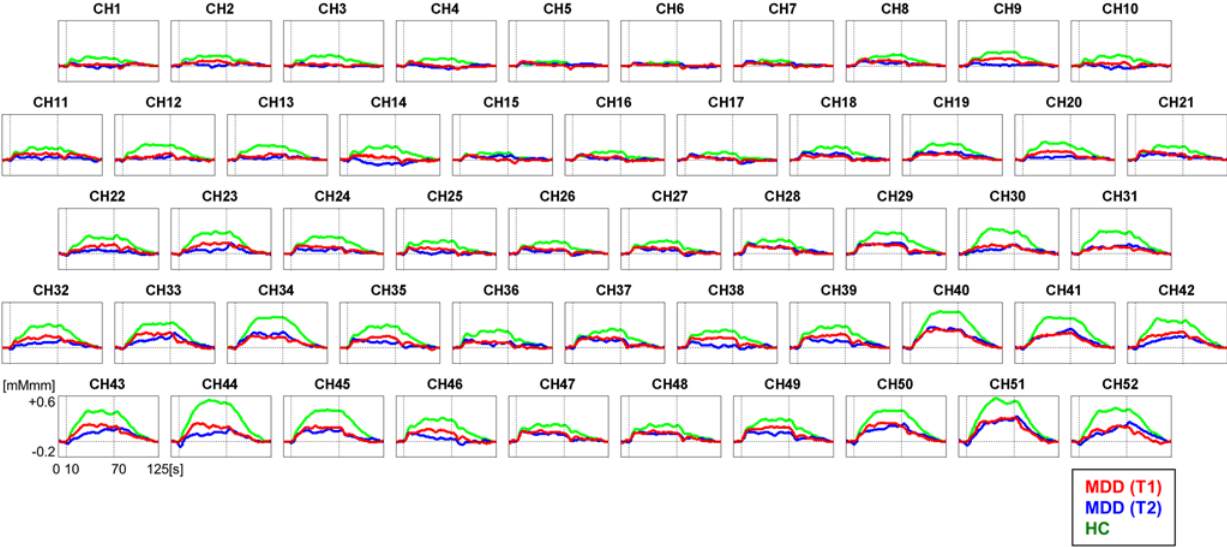
Fig 1. Grand average waveforms of [oxy-Hb] changes during VFT in the fronto-temporal brain regions. Red line represents MDD (T1), blue line represents MDD (T2), and green line represents HC (T1). T1: baseline, T2: after treatment. oxy-Hb, oxygenated haemoglobin signal; VFT, Verbal fluency task, MDD, Major depressive disorder; HC, Healthy